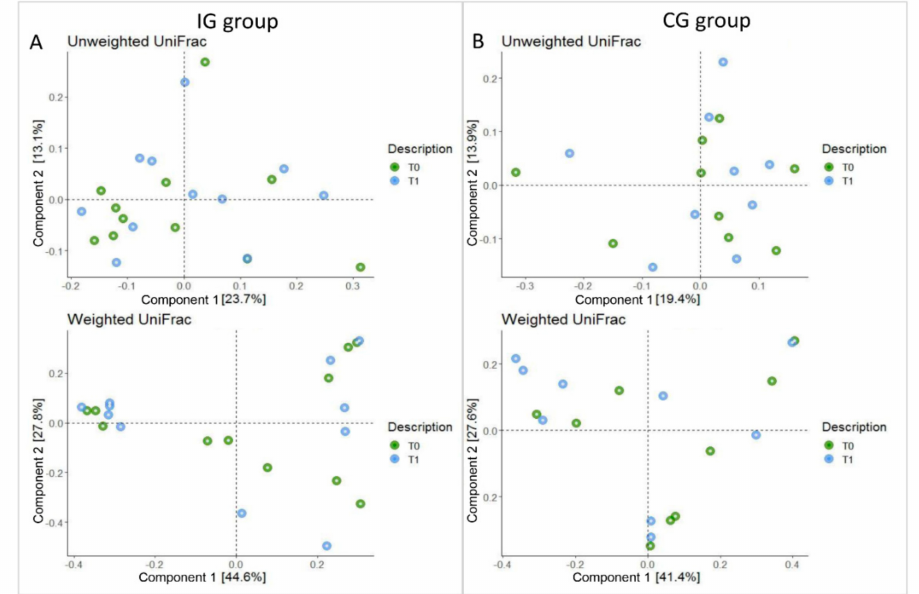
Figure 2. Principal component analysis plot (PCA) of the bacterial communities using UniFrac algorithm. Axes represent the first two components from the principal coordinate (PCo) analysis, based on the phylogenetic distance between operational taxonomic units (OTU) representative sequences. (Panel A ): UniFrac unweighted PCoA and weighted plots of IG group. (Panel B ): unweighted and weighted UniFrac PCoA plots of CG group. T 0 and T 1 refer to baseline and four months of synbiotics administration, respectively.